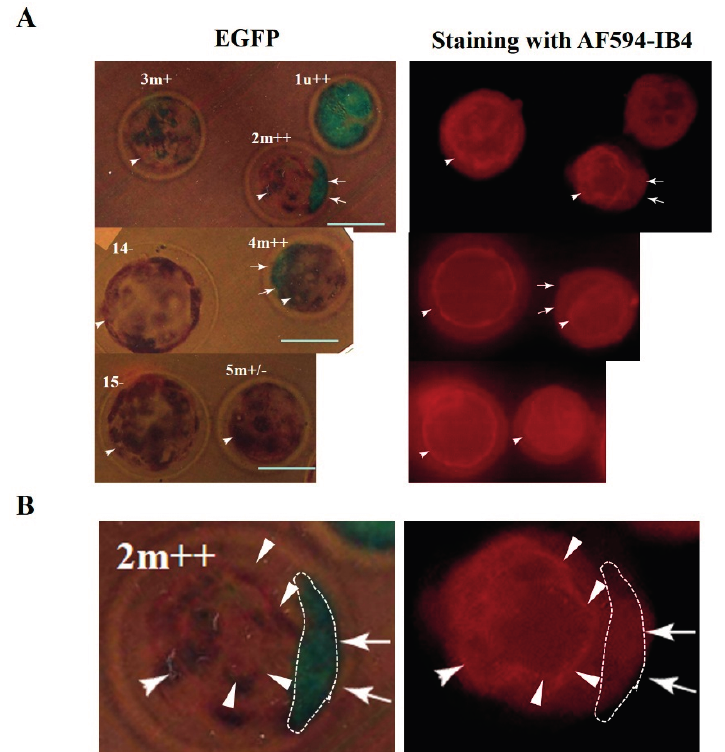
Figure 2. ( A ) Fluorescent images of single blastocysts (1u++, 2m++, 3m+, 4m++, 5m+/ − , 14 − , and 15 − ) developed after oocyte injection with CRISPR/ Cas9 -related mRNA and EGFP mRNA. Blastocysts were fixed for a short period, stained with AF594-IB4, and then inspected for EGFP- and AF594-derived fluorescence under a fluorescence microscope. u++, uniform and strong fluorescence; m++, mosaic and strong fluorescence; m+, mosaic and moderate fluorescence; m+/ − , mosaic and slight fluorescence; − , no fluorescence. Bar = 100 μ m; and ( B ) Magnified images of the 2m++ blastocyst shown in ( A ). The area enclosed by the dotted line shows EGFP-derived fluorescence and reduced α -Gal epitope expression (arrows). The other non-fluorescent area within the same embryos was distinctly stained with lectin, showing a ring-like staining pattern ( arrowheads